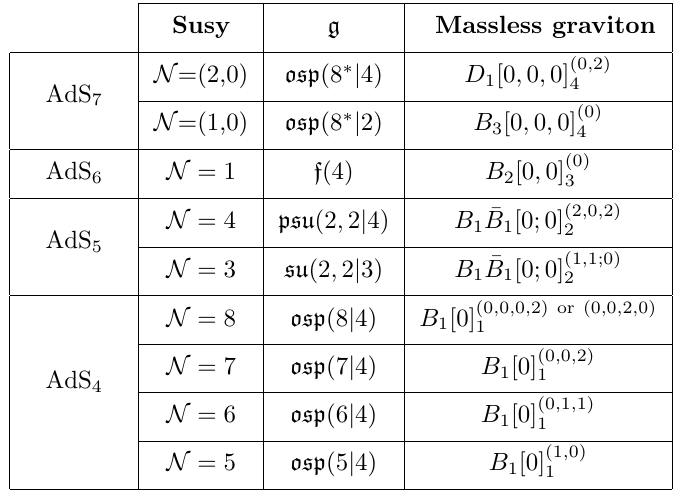
Table 1 . The AdS D supergravities for which the massless graviton is in an absolutely protected representation. We list the number of supersymmetries, the superconformal algebra g , and the absolutely protected representation in the notation of ref. [11]. The list includes all cases in D > 5 dimensions, and all cases with more than half-maximal supersymmetry for reasons explained in the main text. The table has redundancies: when the massless graviton is protected for given ( D; N 0 ) it is also protected for all ( D; N > N 0